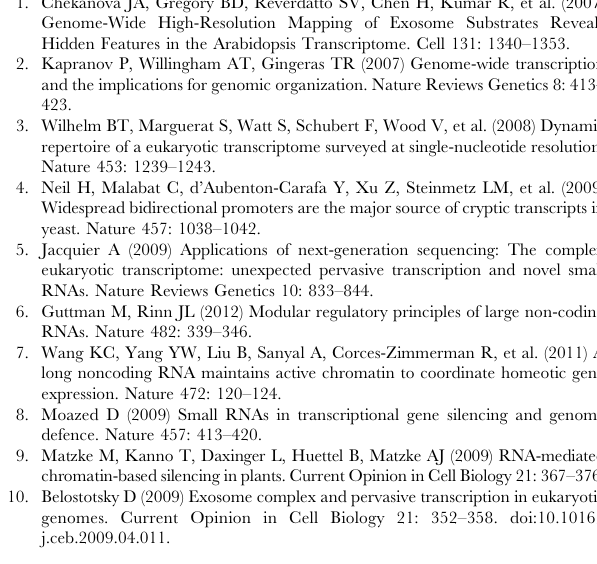
Table S4 Oligonucleotides used in this